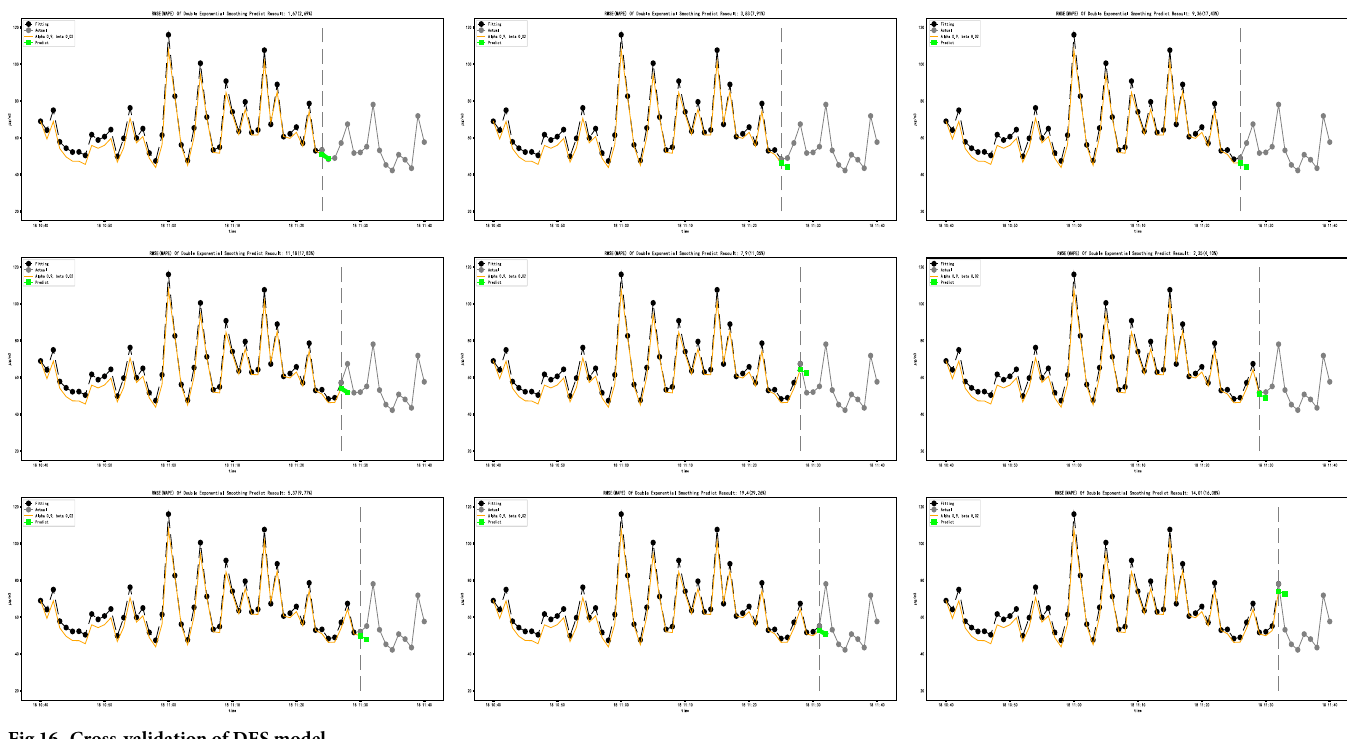
Fig 16. Cross-validation of DES